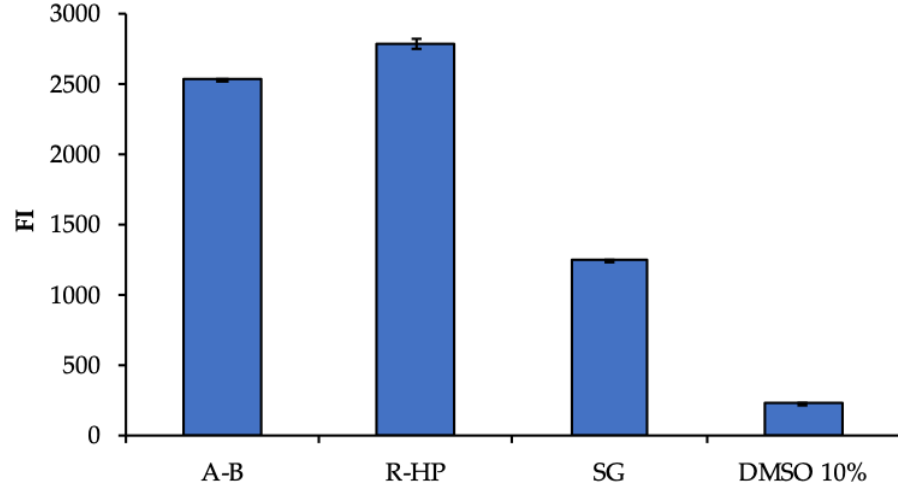
Figure 7. Viability (FI, fluorescent intensity) of human adipose stem cells (hASCs) grown for 3 days in the presence of extracts from the two parts of the scaffold (R-HAP and A-B). GM (growth medium) and 10% DMSO were used as positive and negative controls, respectively (mean values ± sd; n = 8). ANOVA one-way; Scheffé test: A-B vs R-HAP: p < 0.01; A-B vs GM: p < 0.01; A-B vs DMSO 10%: p < 0.01; R-HAP vs GM: p < 0.01; R-HAP vs DMSO 10%: p < 0.01; GM vs DMSO 10%: p < 0.01.